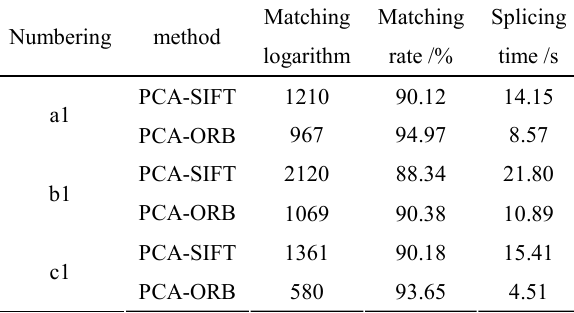
Table 1. Comparison of two algorithms